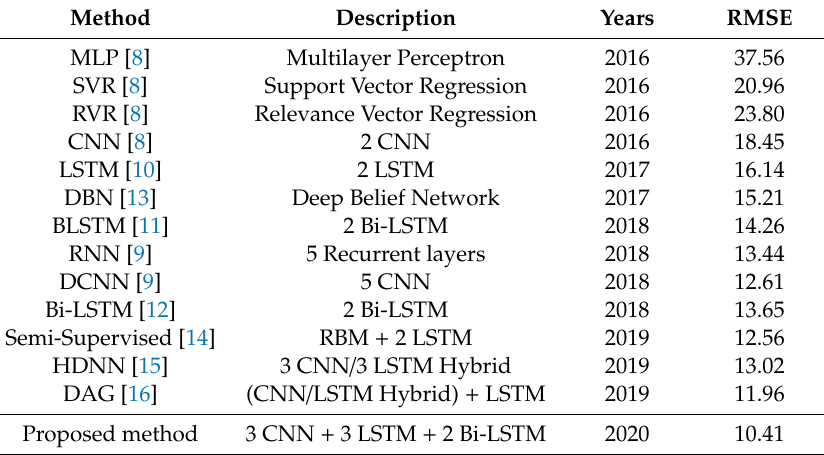
Table 4. Comparison of the prognosis RMSE results with other